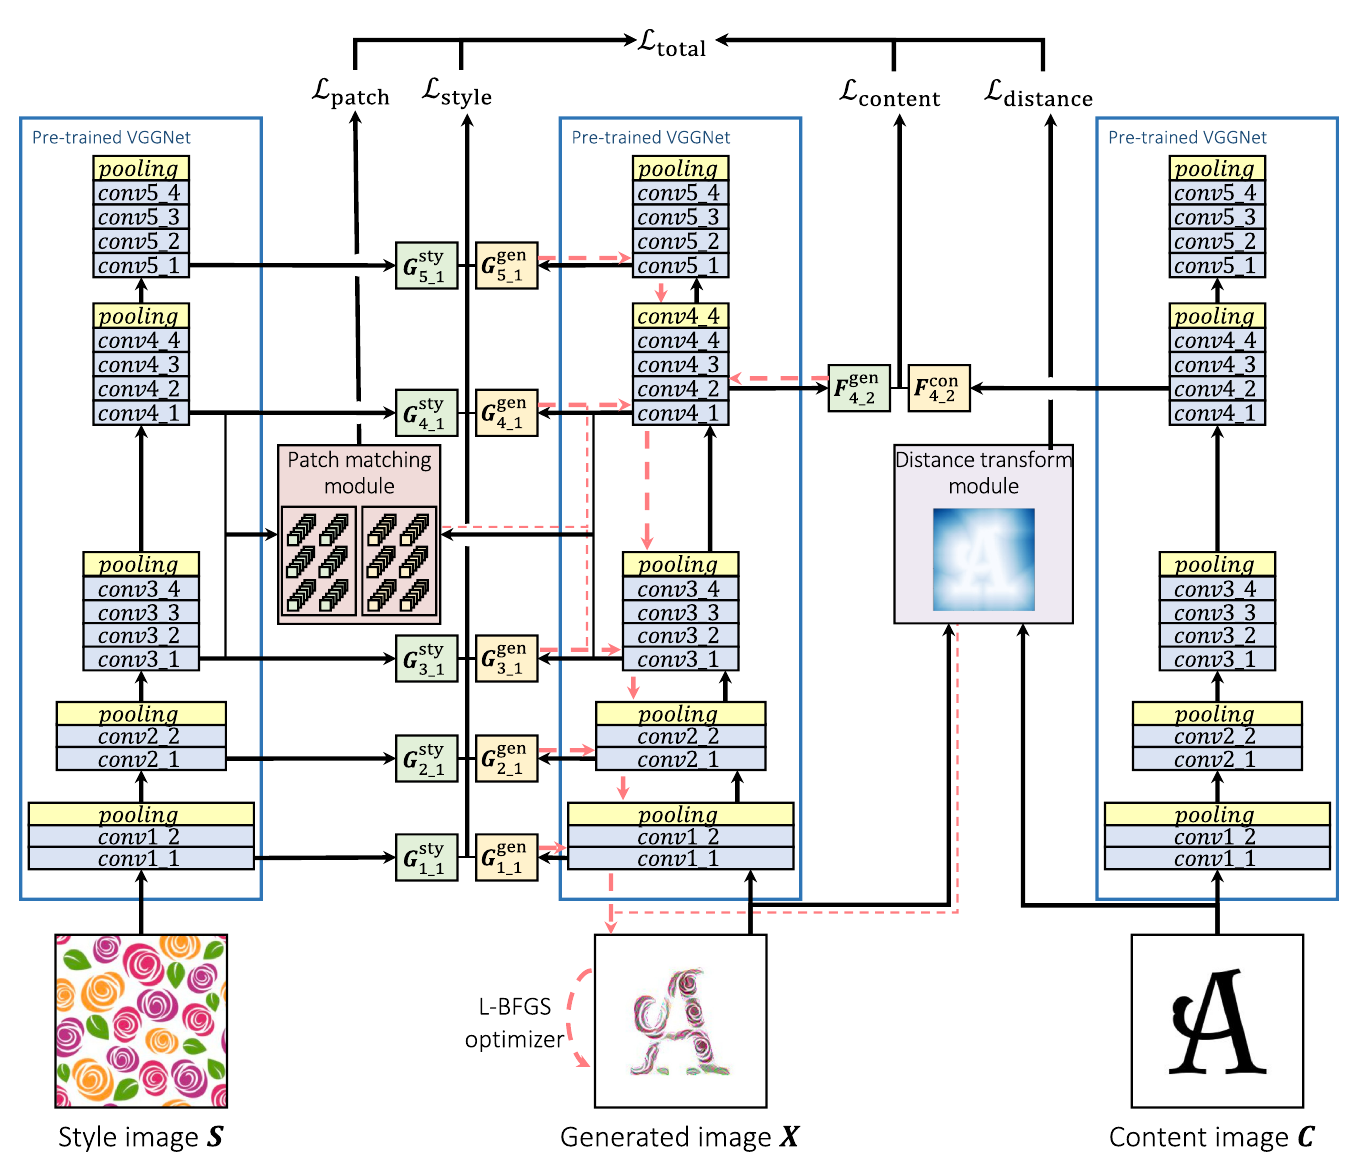
Fig 4. The process flow of the proposed method. Black arrows show forward operations and red arrows show back-propagation. Details of the “Distance transform module” is shown in Fig 7 and the “Patch matching module” is in Fig 8.